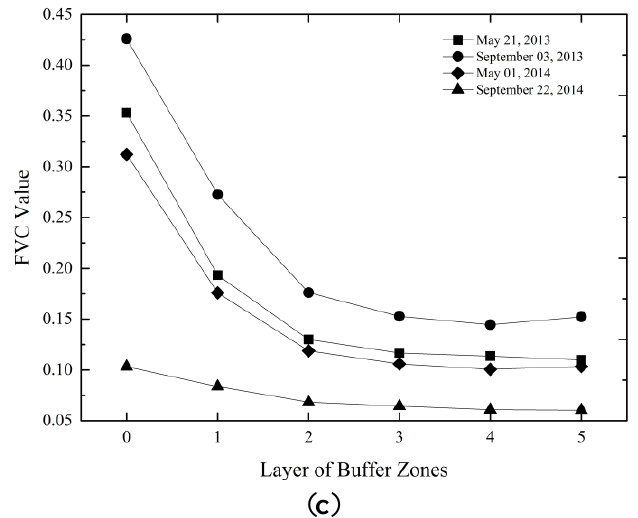
Figure 9. ( a ) GVI average value in the core areas and each layer of the buffer zones; ( b ) SAVI average value in the core areas and each layer of the buffer zones; ( c ) FVC average value in the core areas and each layer of the buffer zones. The zero points on the x axis refers to core areas.